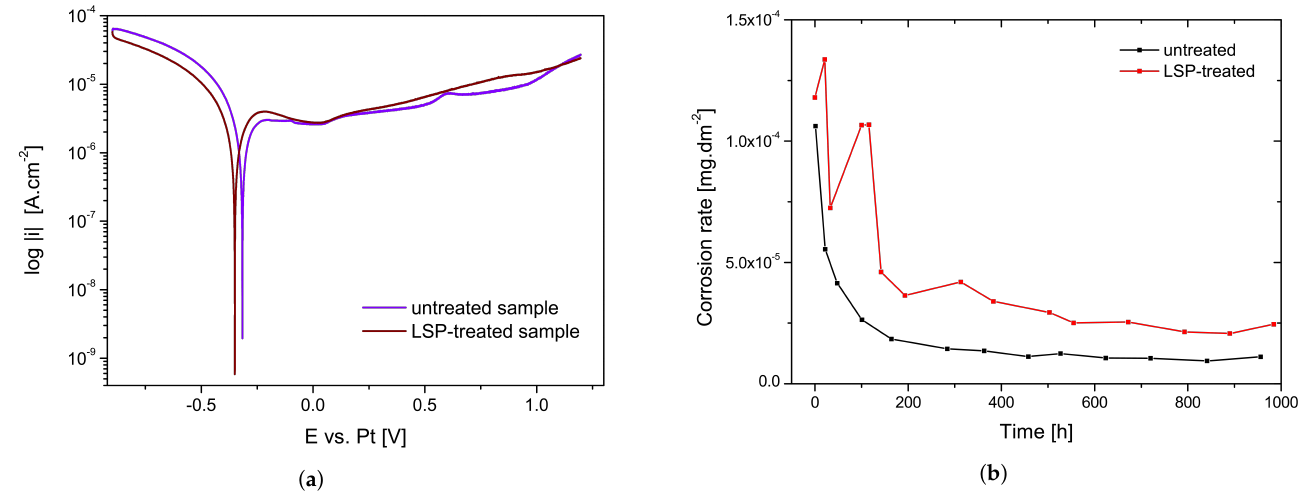
Figure 12. ( a ) Polarization curves. ( b ) Instantaneous corrosion rate of untreated and LSP-treated specimen.